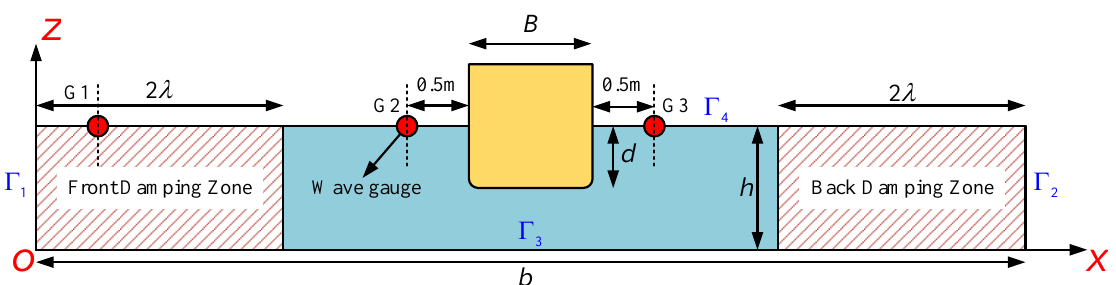
Figure 1. Schematic diagram of the two-dimensional numerical wave flume (2D NWF), the stationary surface-piercing body and three wave